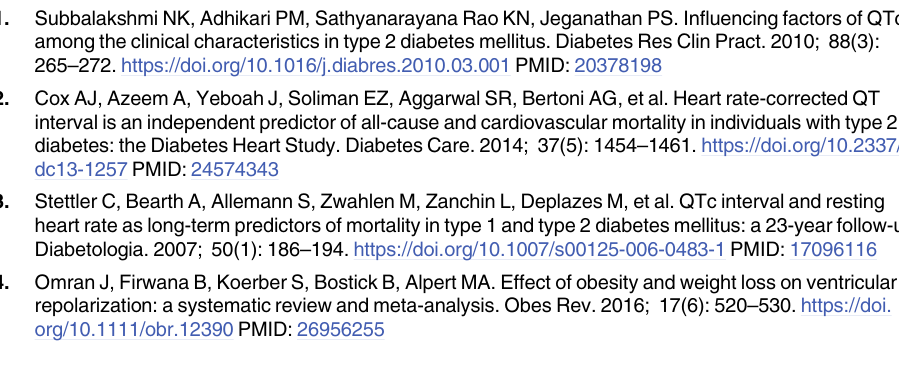
Strengthening the Reporting of Observational studies in Epidemiology. S1 Fig. The distribution of QTc interval(A), M-FPG(B), M-PPG(C), SD-FPG(D), SD-PPG (E) and HbA1c(F). M-FPG: mean of fasting plasma glucose; M-PPG: mean of postprandial plasma glucose; SD-FPG: standard deviation of fasting plasma glucose; SD-PPG: standard deviation of postprandial plasma